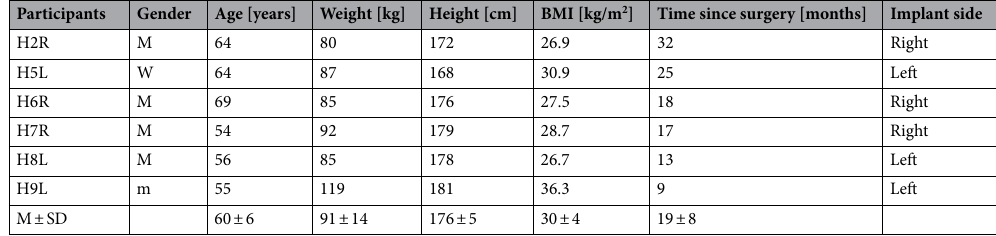
Table 1. Patients participated; M mean, SD standard deviation, BMI body mass